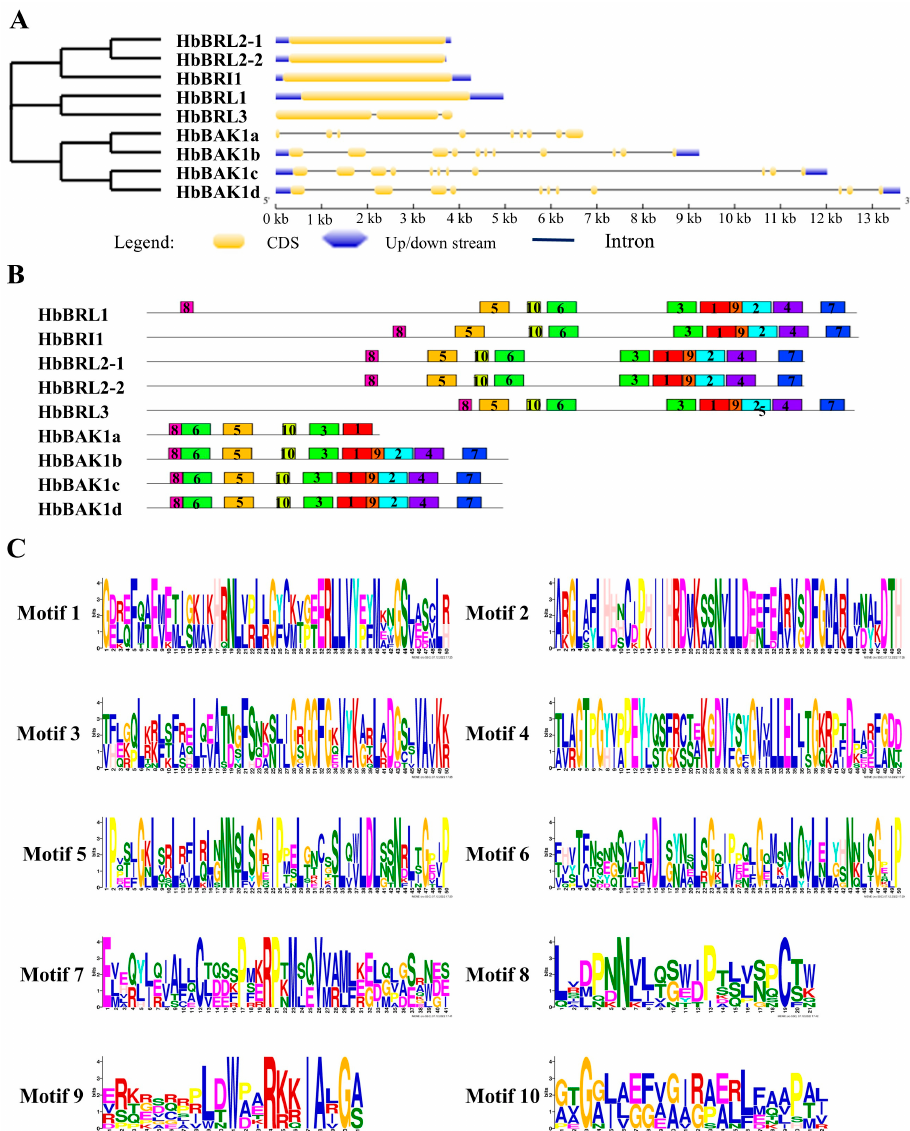
Figure 4. Gene structure and conserved motifs in five HbBRI1 and four HbBAK1 members. ( A ) Phy- logenetic trees of HbBRI1 and HbBAK1 were compared by using MEGA X with the NL method. Gene structures of HbBRI1 and HbBAK1 genes were analyzed by GSDS. Yellow strips represent CDS, black lines delegate introns and blue strips indicate up/downstream. ( B ) Motifs in HbBRI1 and HbBAK1 members. Conserved motifs in HbBRI1 and HbBAK1, as executed by the MEME program, are displayed in the panel. Colored boxes represent different conserved motifs. ( C ) The sequence logo of the motifs. Motifs are shown by stacks of letters in each site. The height of the letters indicates that the letter appearing in the position is multiplied by the total amount of information on the stacks.